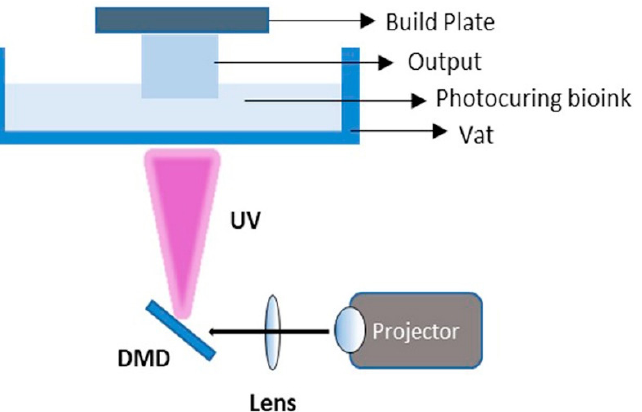
Figure 2. Schematic illustration of DLP-printing process. DMD: Digital micromirror device. Adapted from [39] with permission from